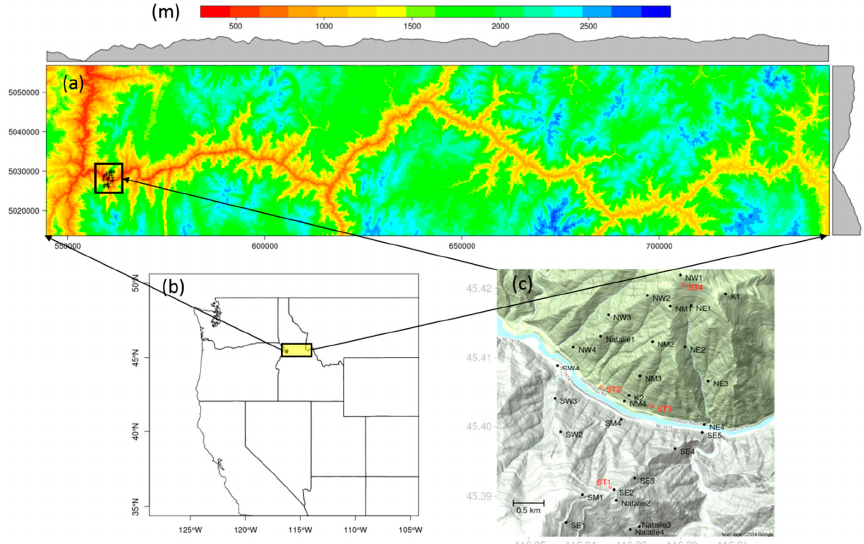
Figure 1. Study area and surrounding terrain. ( a ) Digital elevation model of the Salmon River Canyon and surrounding terrain; the small black crosses indicate wind sensor locations. ( b ) Geographic location of the Salmon River Canyon; the yellow box denotes the location Salmon River Canyon; the black circle indicates the study area. ( c ) Hillshade of the study area with wind sensor locations.